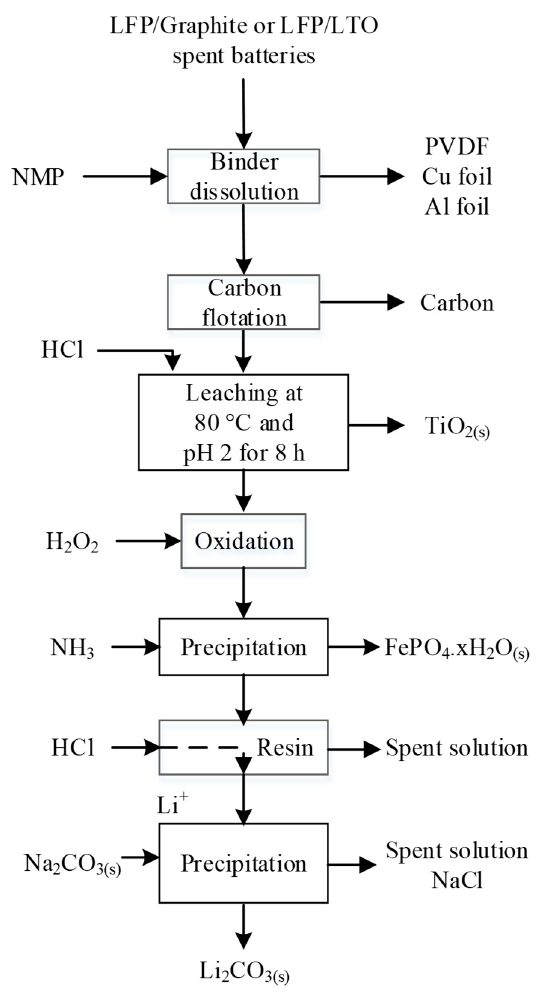
Figure 11. HCl leaching process proposed by Laucournet et al. (according to [164]); here LFP, LTO, and PVDF are for LiFePO 4 , Li 4 Ti 5 O 12 , and polyvinylidene fluoride, respectively. As in the sulfate system, recovery of valuable elements in the chloride system can be precipitated as hydroxides or carbonates [74,169]. Freitas et al. used electrodeposition and electrowinning as refining and extraction steps, respectively, at the end of which metallic cobalt was recovered [162].